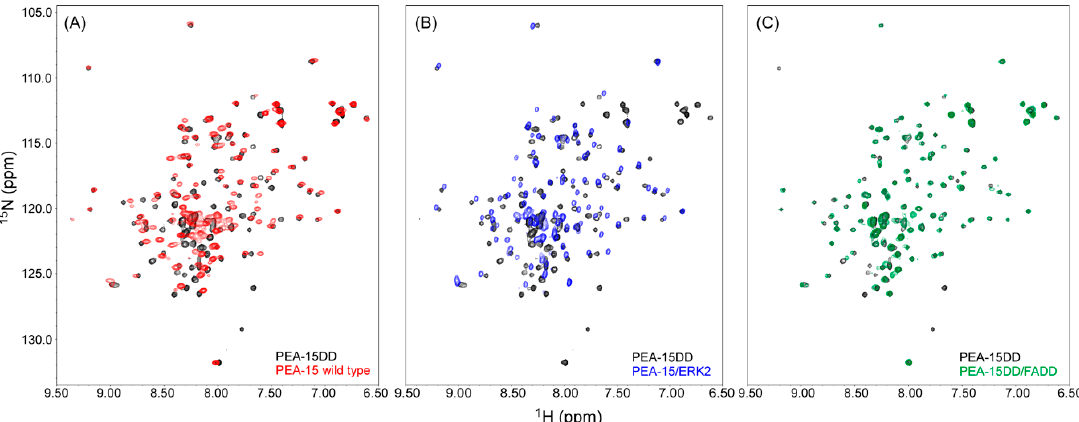
Figure 4. Two-dimensional (2D) heteronuclear single-quantum coherence (HSQC) nuclear magnetic resonance (NMR) spectrum of the PEA-15 S104D / S116D double mutant (PEA-15DD) (black) superimposed with the spectra of ( A ) the wild-type PEA-15 (red); ( B ) the wild-type PEA-15 in the complex with ERK2 (blue), and ( C ) PEA-15DD in the complex with Fas-associated death domain (FADD) (green).